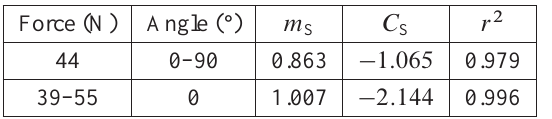
Table 1. The values of the above constants found by linear regression.